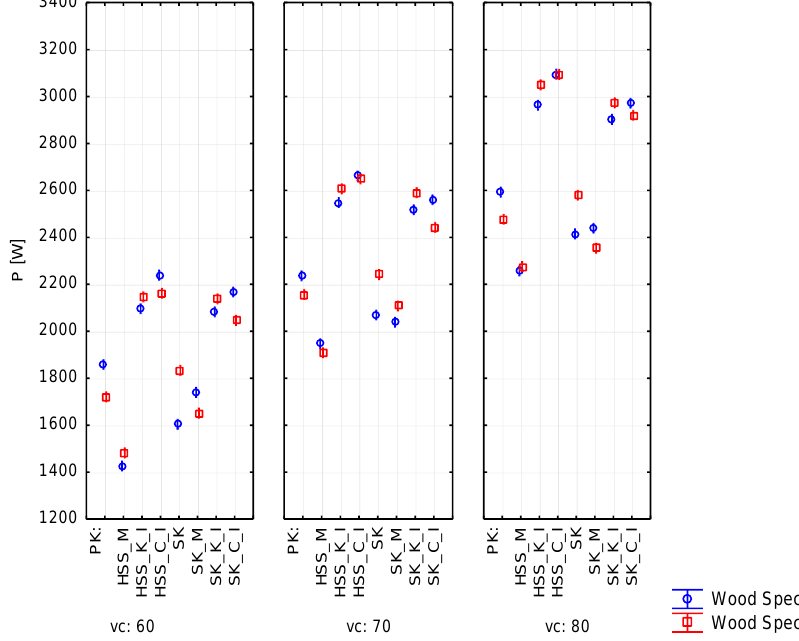
Figure 8. Average power values depending on the coating used and the cutting speed.